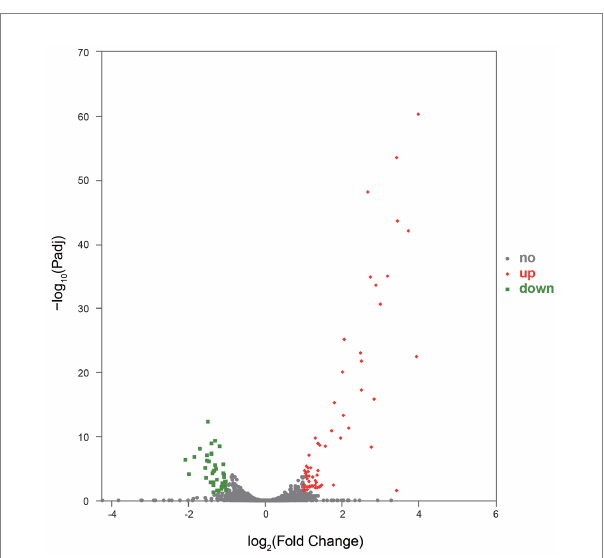
FIGURE 5 The SDE genes between the control and treatment groups. No indicates the gene with significantly non-regulated expression and abs(FoldChange) <1 or Padj >0.05. Up indicates the gene with significantly upregulated expression, log 2 FoldChange ≥ 1, and Padj ≤ 0.05. Down indicates the gene with significantly downregulated expression, log 2 FoldChange ≤ − 1, and Padj ≤